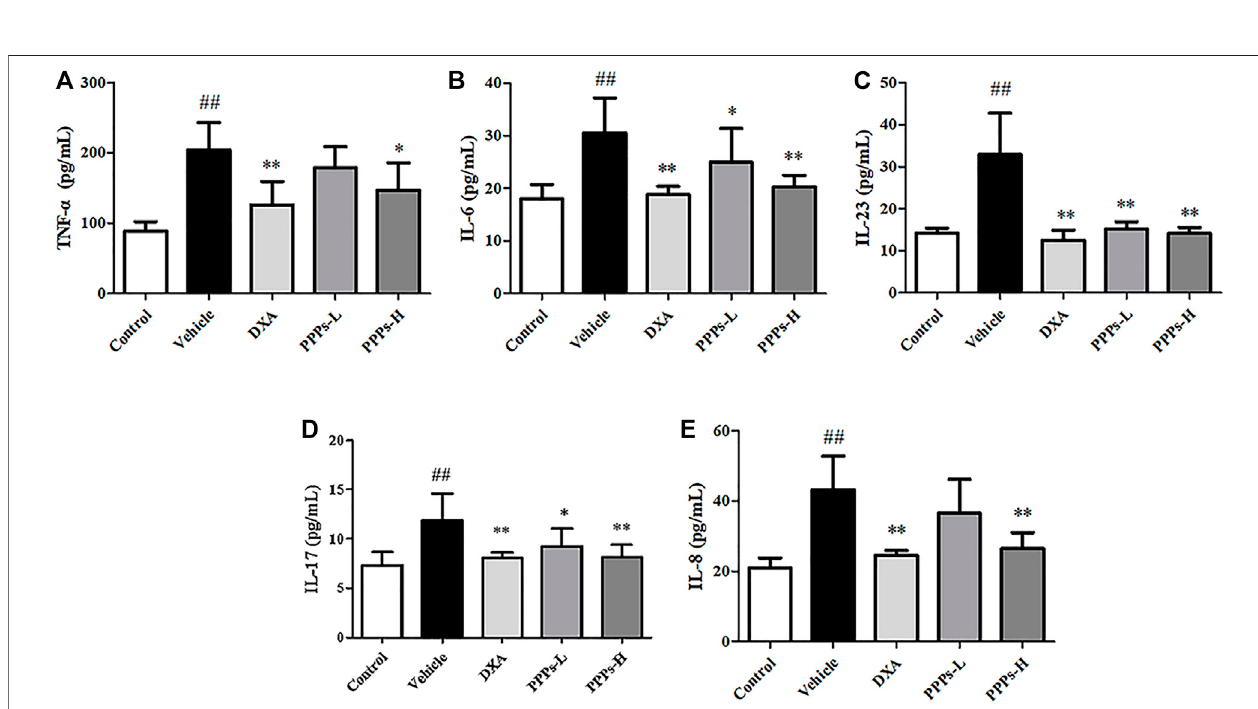
FIGURE 6 | Punica granatum peel polysaccharides (PPPs) decreased the levels of in fl ammatory mediators in mice with imiquimod (IMQ)-elicited psoriasis. The levelsofthein fl ammatorymediatorsTNF- α (A) ,IL-6 (B) ,IL-23 (C) ,IL-17 (D) ,andIL-8 (E) weremeasuredbyELISAintheserumofIMQ-inducedpsoriasis-likemice.Data areshownasthemean ± SD( n (cid:1) 6). # p < 0.05, ## p < 0.01comparedwiththecontrolgroup;* p < 0.05,** p < 0.01comparedwiththevehiclegroup. PPPs-L ,low-dose PPPs; PPPs-H , high-dose PPPs.